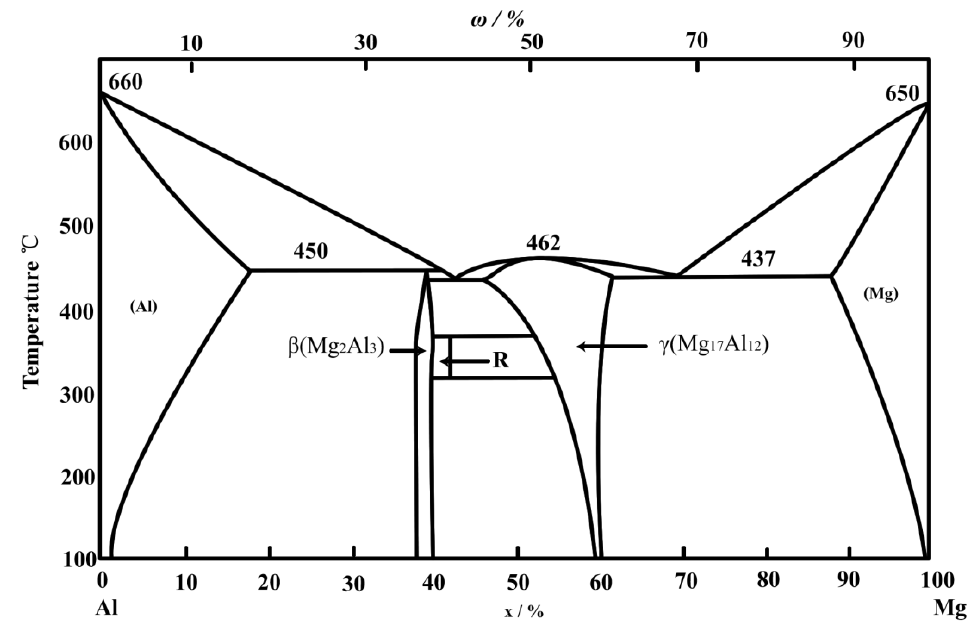
Figure 1. Al-Mg binary phase diagram